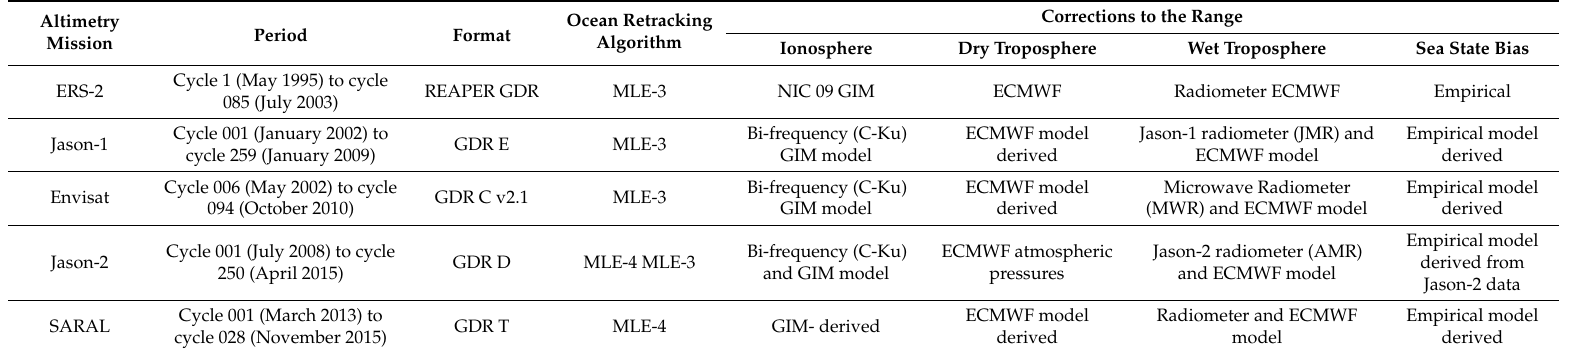
Table 2. Ocean ranges available and corrections for each altimetry